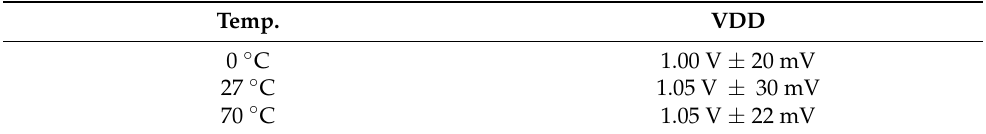
Table 2. Measured V DD vs. temperature.